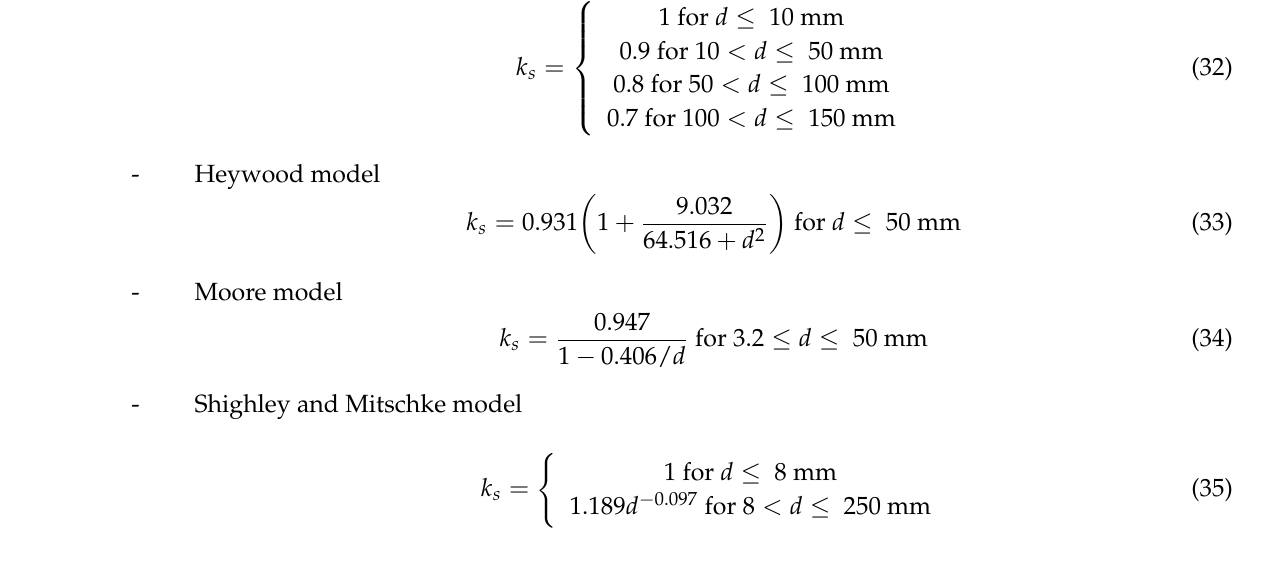
Table 3. Size factor [54].